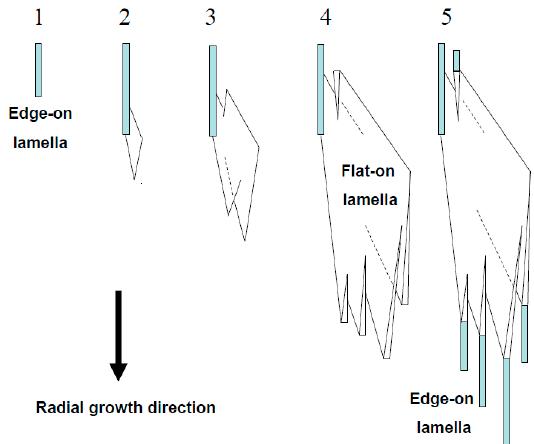
Figure 12. Scheme showing the details of growth and organization of the twisted lamellar crystals. The lamellar crystals change orientation via twisting. Macro screw dislocations lead to multiplication of lamellar crystals and synchronous twisting of neighboring lamellae. Redrawn with permission from Ref. [49]. Copyright (2007) Elsevier, Ltd.